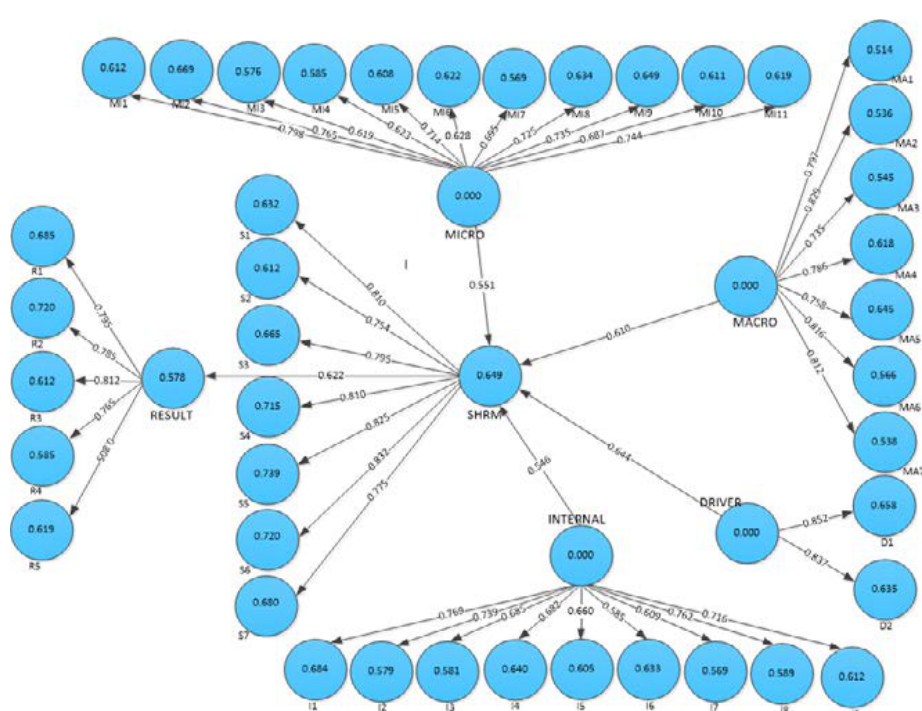
Fig. 2: Structural model of the research in the case of significant coefficients